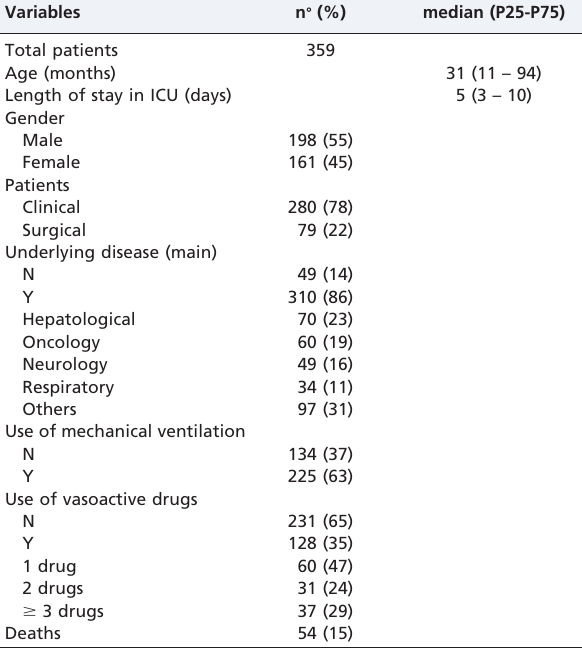
Table 3 - Risk factors for death.